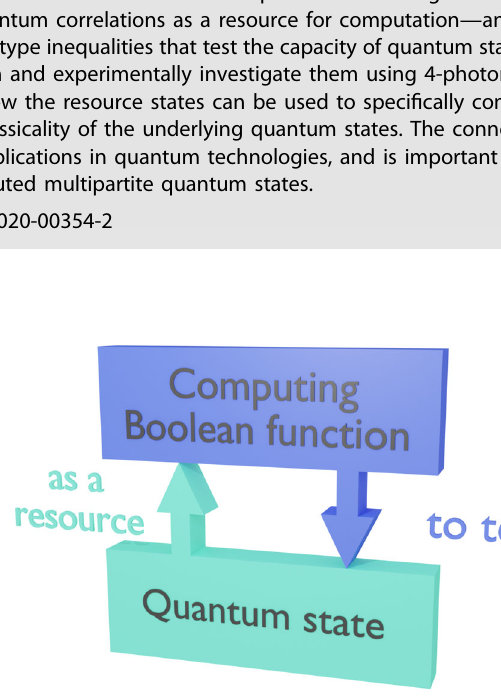
Fig. 1 Duality. Illustration of the dual link between quantum states and computing Boolean functions: We can derive Bell-like inequal- ities to test whether certain quantum states can be used as a resource for computation. Vice versa, we can use the computation of Boolean functions as a test of quantum